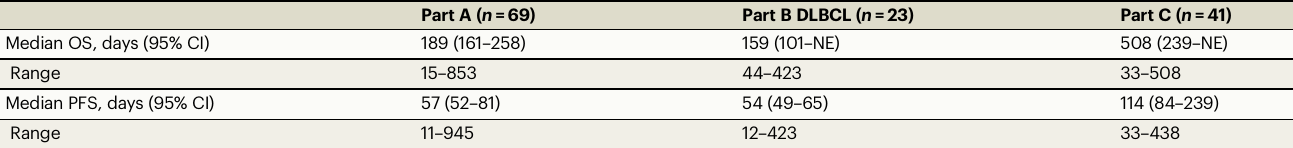
Table 2 | Median overall and progression-free survival